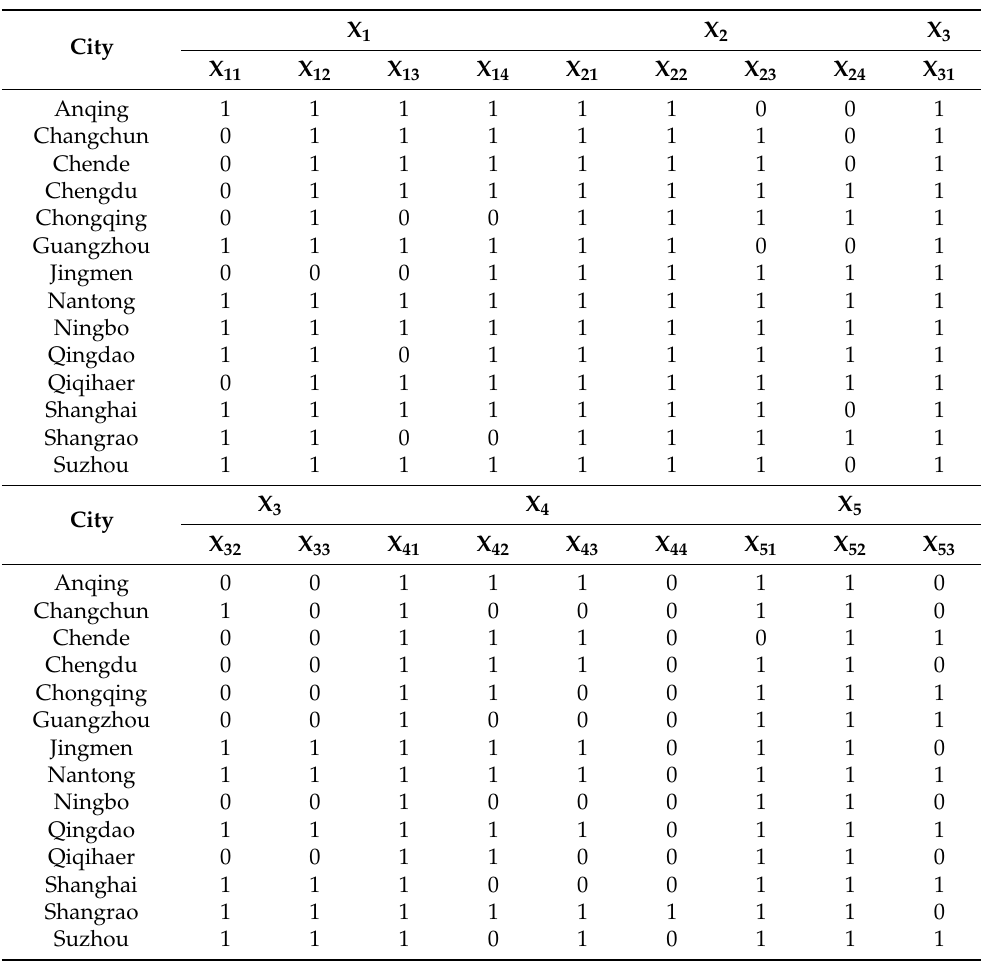
Table A2. The multi-input-output table for calculating the PMC